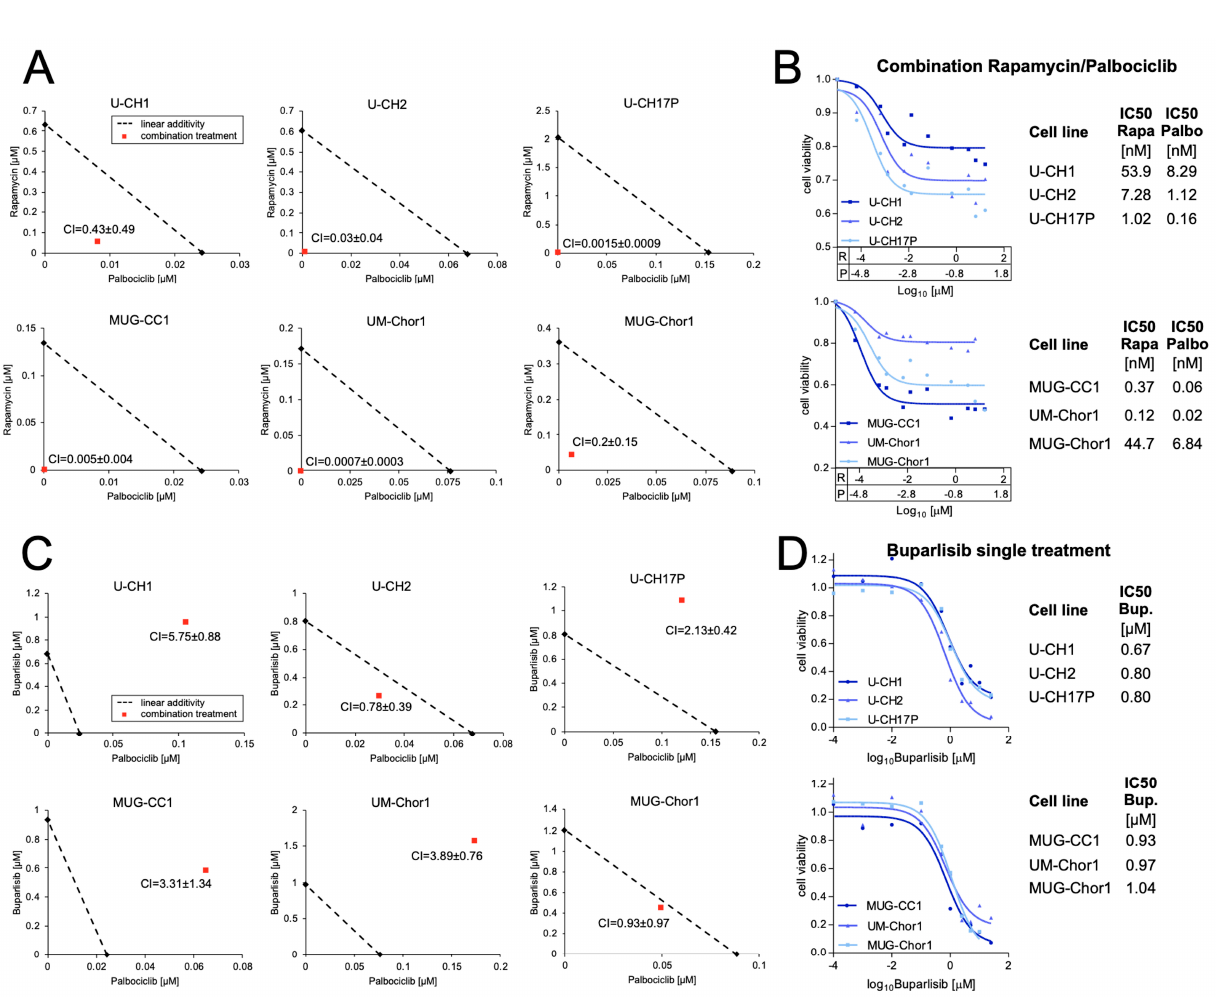
Figure 3. Targeting CDK4/6 and PI3K/AKT/mTOR signaling in chordoma cell lines. Isobolograms of the treatments with palbociclib in combination with rapamycin ( A ). Inhibition curves and the corresponding IC50 values of the combination treatment with rapamycin (R/Rapa) and palbociclib (P/Palbo) ( B ). Isobolograms of palbociclib combined with buparlisib ( C ) and inhibition curves of buparlisib monotherapy as well as corresponding IC50 values ( D ) in six chordoma cell lines. To assess whether the treatments affect the activity of PI3K signaling, Western blot analyses were performed: chordoma cell lines were treated for six hours with buparlisib monotherapy or a combination of palbociclib (0.5 µM) and rapamycin (1 µM). In all six of the cell lines tested, buparlisib reduced the protein levels of phospho-S6-kinase. Phospho-AKT levels decreased in U-CH1, MUG-Chor1, UM-Chor1, and MUG-CC1. Due to the low levels of p-AKT in untreated U-CH2 and U-CH17PII cells, no further reductions were observable following buparlisib treatment. No effect was seen on phospho-ERK (Figure 4A). In all of the cell lines, Western blot analyses revealed that palbociclib alone did not affect the activity of PI3K signaling; however, treatment with rapamycin reduced the phosphorylation of the mTORC1 downstream target S6 kinase (Figure 4B).